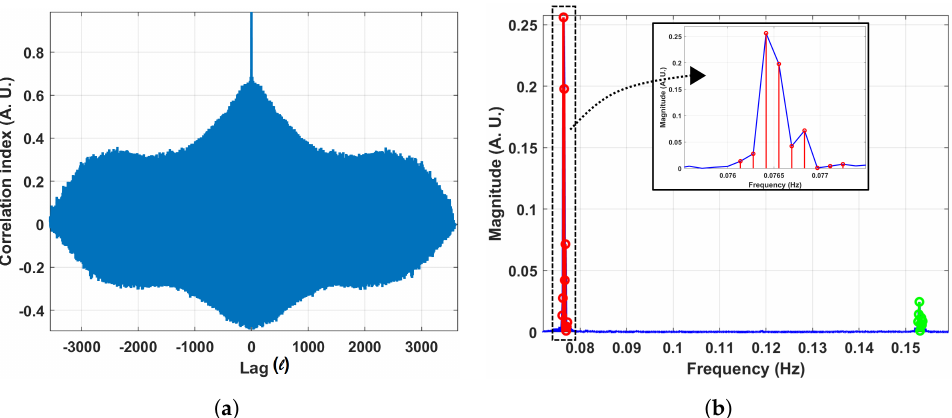
Figure 5. Results for the experimental run where the distance d between the fan and the anemometer was 0.50 m. ( a ) Correlogram; ( b ) Frequency spectrum where the HESD is highlighted in red. Table 1. Evaluation of the f -airflow modeling (AFM) algorithm in semi-controlled environments, summary of